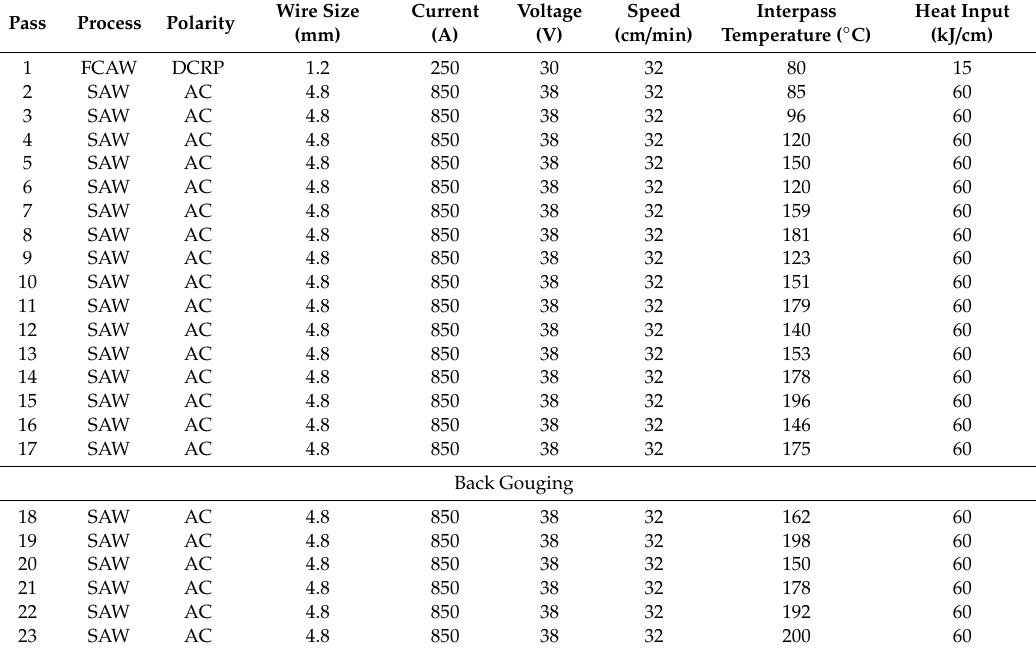
Table 2. Submerged arc welding (SAW) conditions for the 70 mm thick plate.